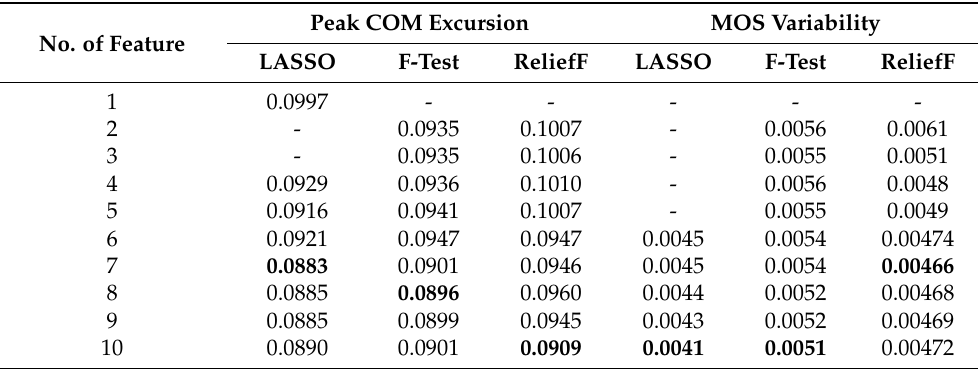
Table 5. Comparison of prediction error (MAE) for each feature selection method in peak COM excursion and MOS variability.